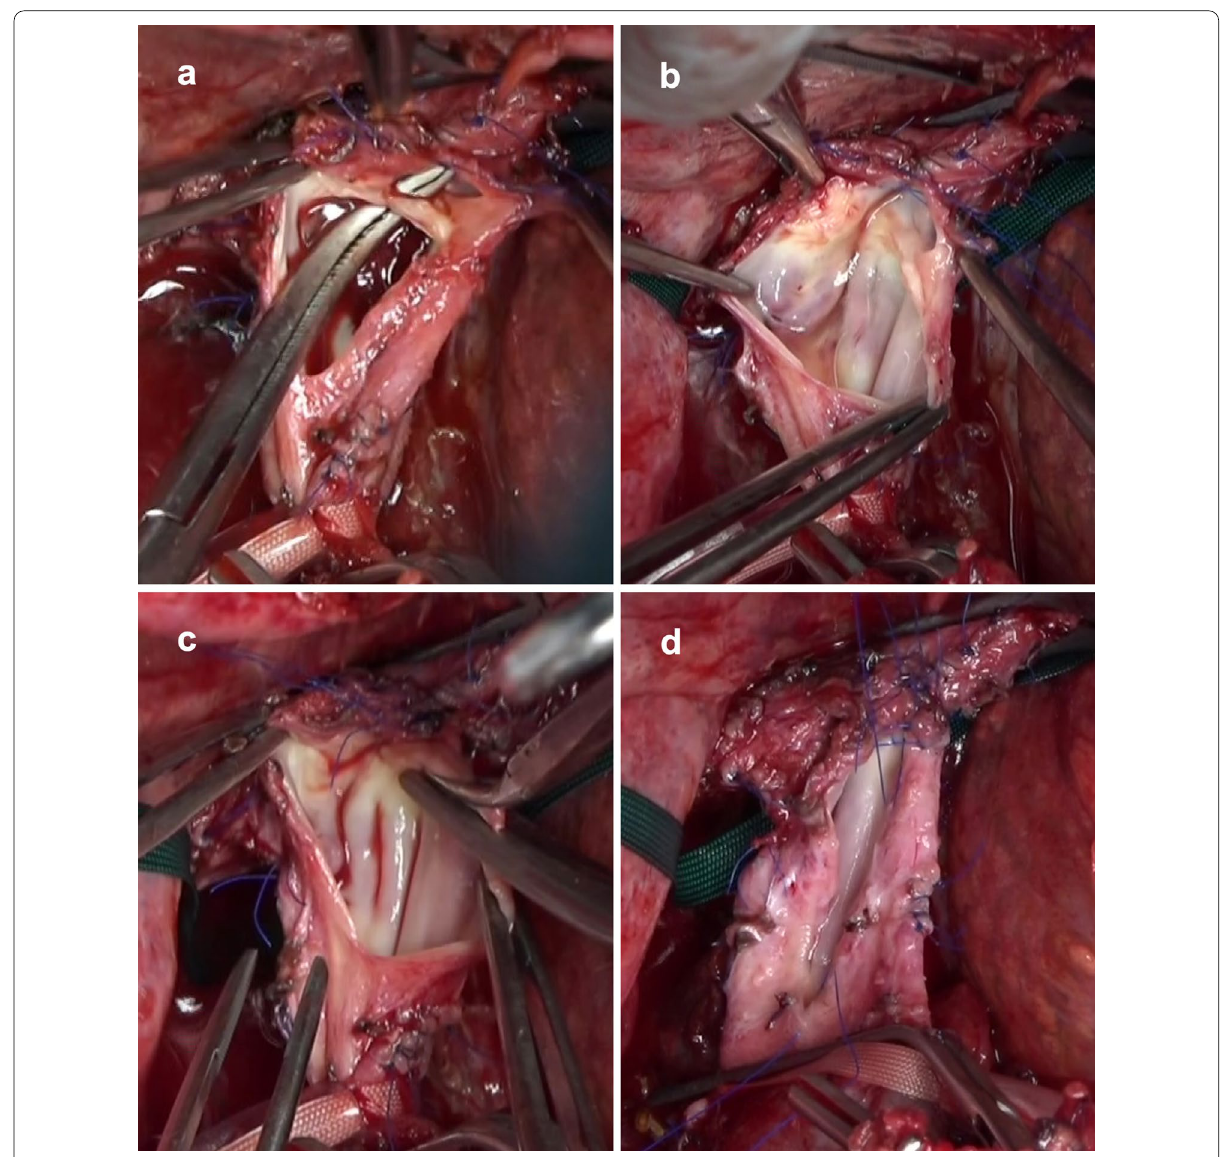
Fig. 4 Resection of the membranous web in the suprahepatic inferior vena cava (IVC) and creation of the orifice for patch cavoplasty. a Severe stenosis is seen when the suprahepatic IVC was opened. b The membranous web in the IVC. c Resection of the membranous web. d Creation of the anastomotic orifice for patch